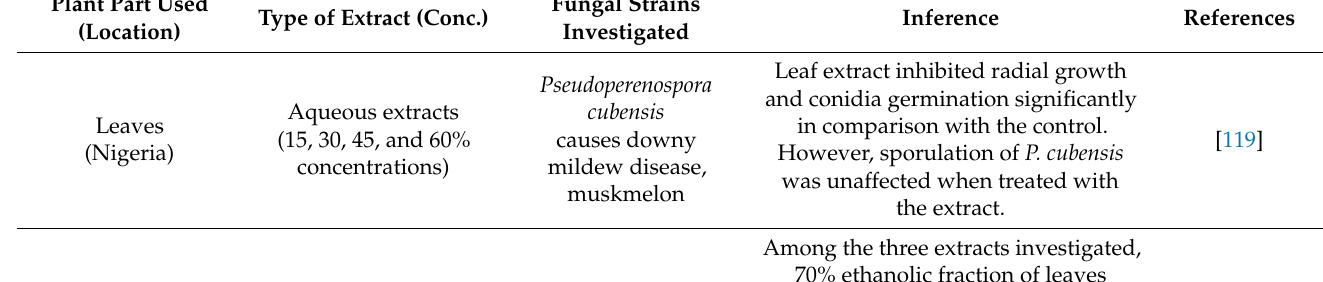
Table 3. Evidence of the activity of essential oil/different extracts from Ageratum conyzoides against important fungal strains. Plant Part Used Type of Extract (Conc.) (Location)